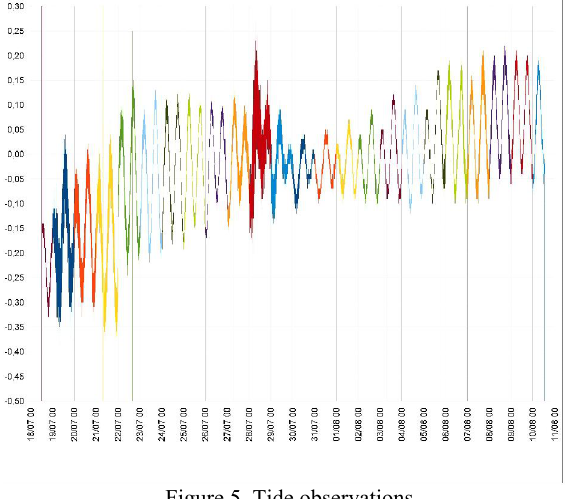
Figure 5. Tide observations